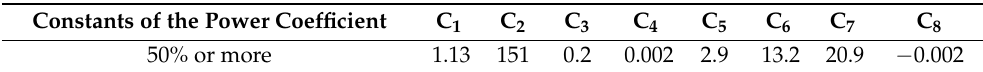
Table 3. Constants of the power coefficient.